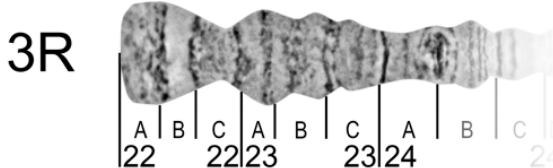
Figure 8. Chromosome division, numbering, and lettering (peritelomeric region of 3R An. beklemishevi as an example).